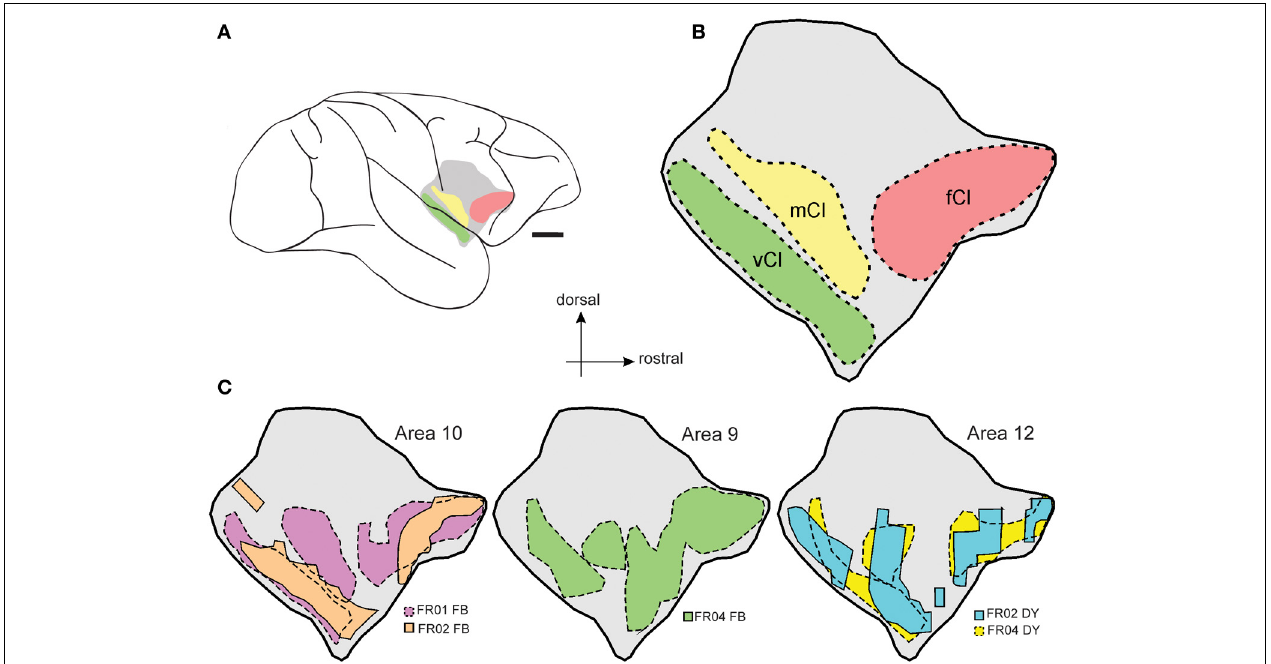
FIGURE 6 | Summary of claustrum-prefrontal projections. Regions of the Cebus claustrum as defined by Gattass et al. (this volume) are schematically displayed as color coded regions in (A,B) . (C) illustrates the smoothed outline